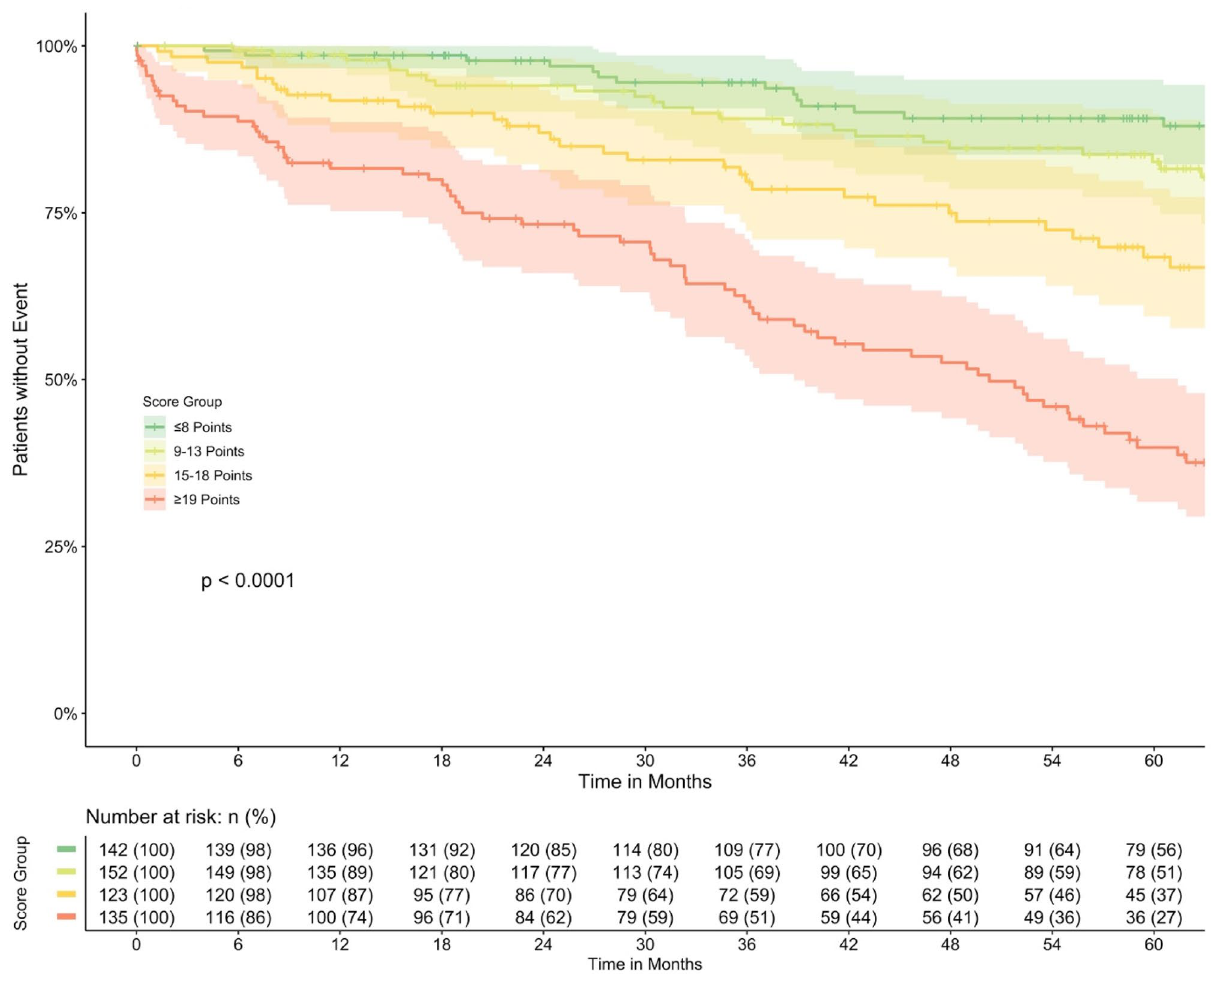
Figure 2. Survival Curves of Predictive Score. Kaplan–Meier Estimators with corresponding 95% confidence interval for overall survival stratified by risk score. Log-rank test was used to compare difference in